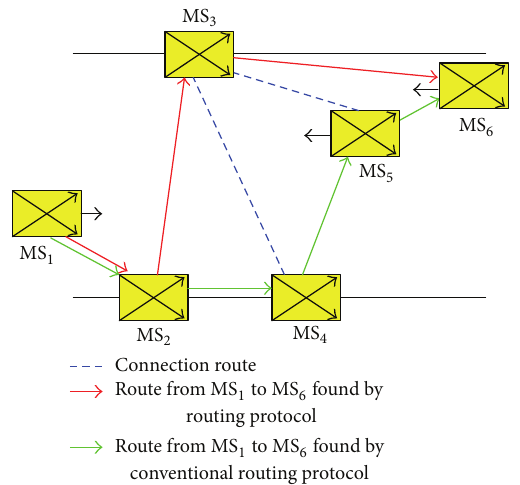
Figure 11: An example of a route from MS 1 to MS 6 found by using the proposed routing protocol.